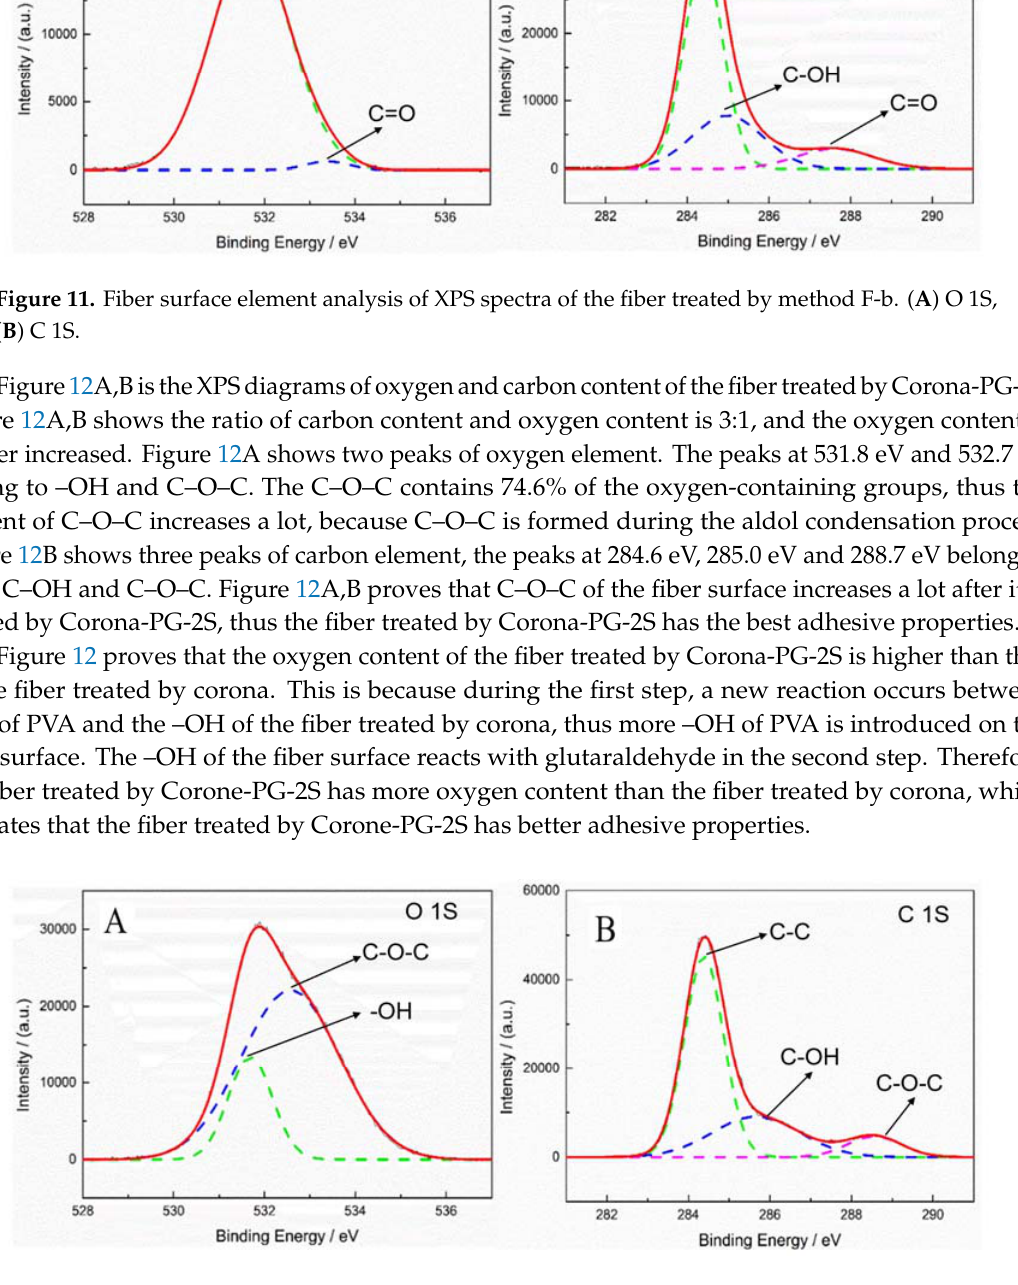
Figure 12. Fiber surface element analysis of XPS spectra of the fiber treated by method F-f. ( A ) O 1S, ( B ) C